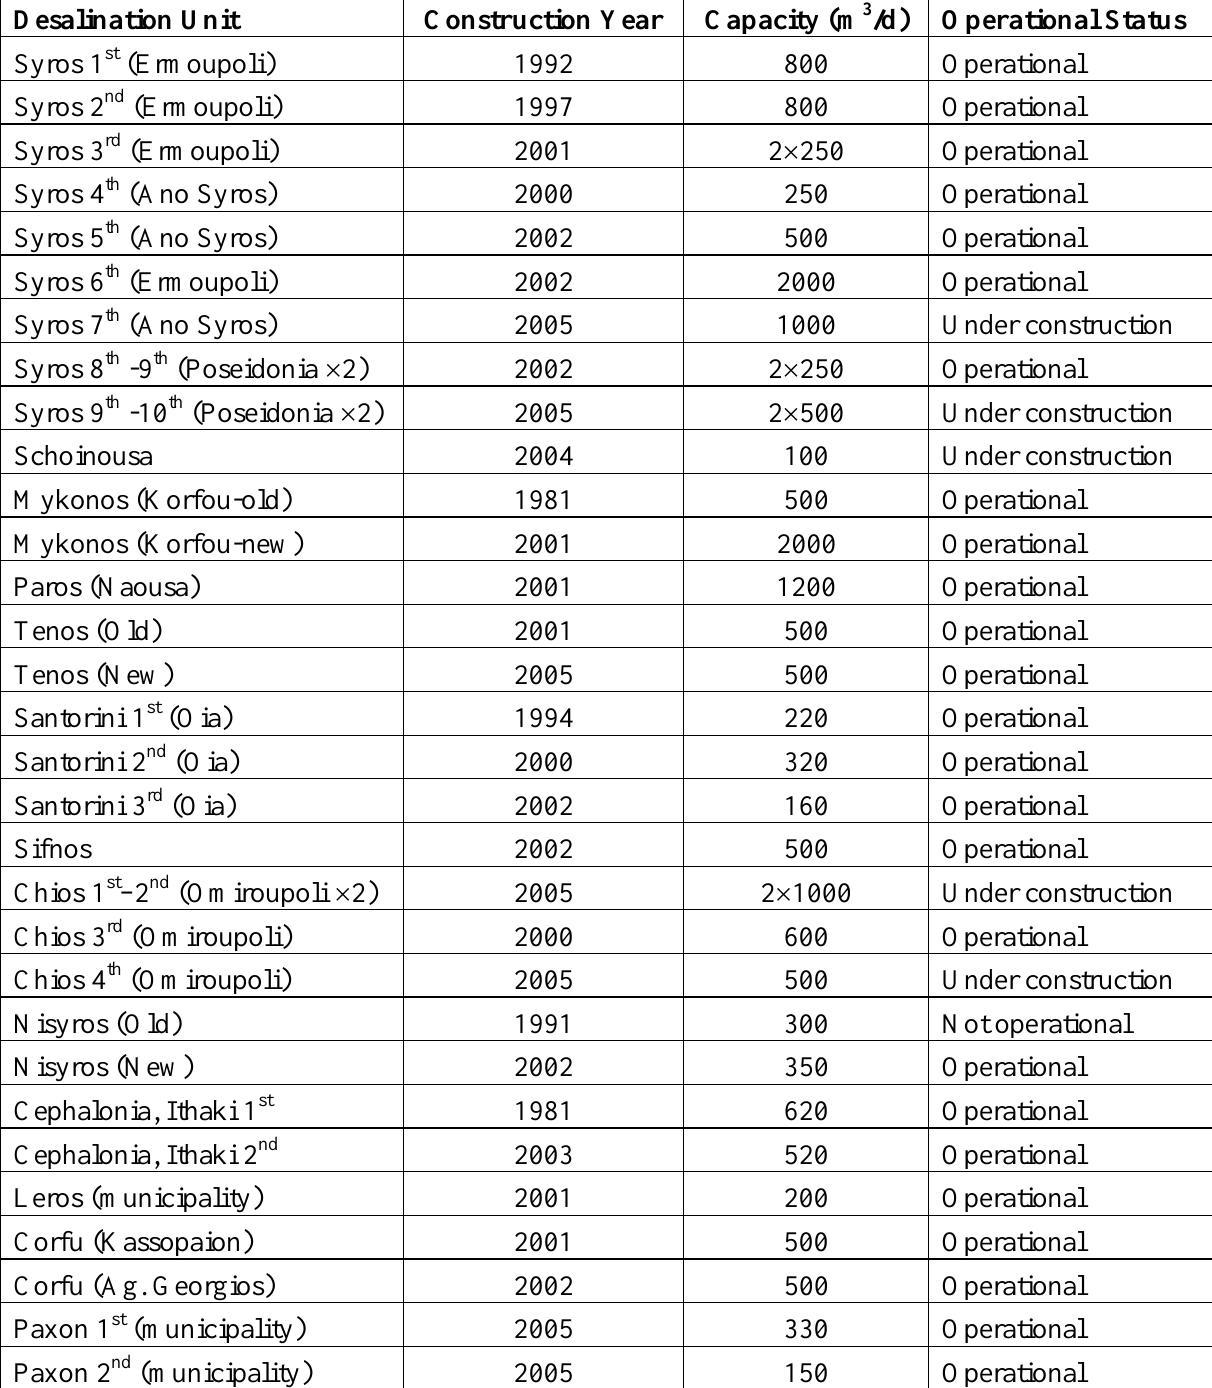
Table 1. Desalination plants in Greece (adapted from